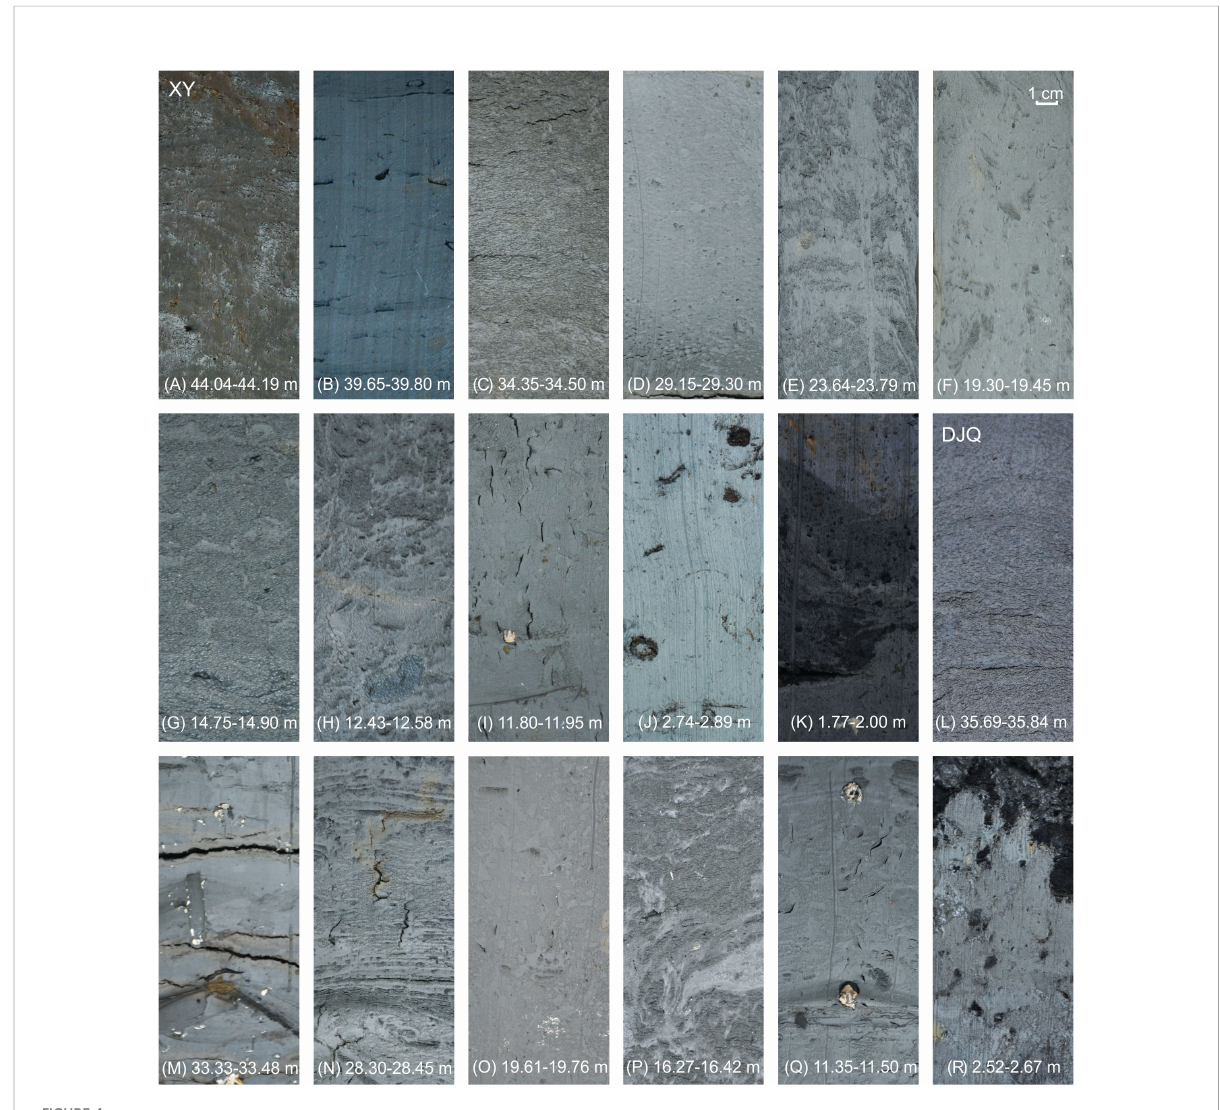
FIGURE 4 Photographs of typical lithological elements in cores XY (A – K) and DJQ (L – R)